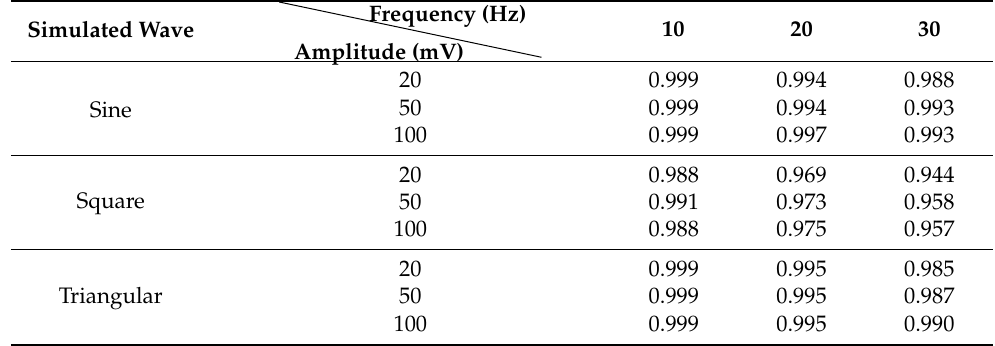
Table 1. Normalized cross-correlation coefficients for simulated input signals and recorded output signals. Simulated